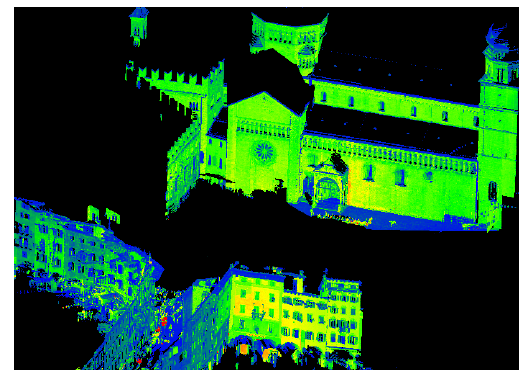
Figure 5. TLS ultra-dense reconstruction of two symmetrical buildings in the Duomo square of Trento